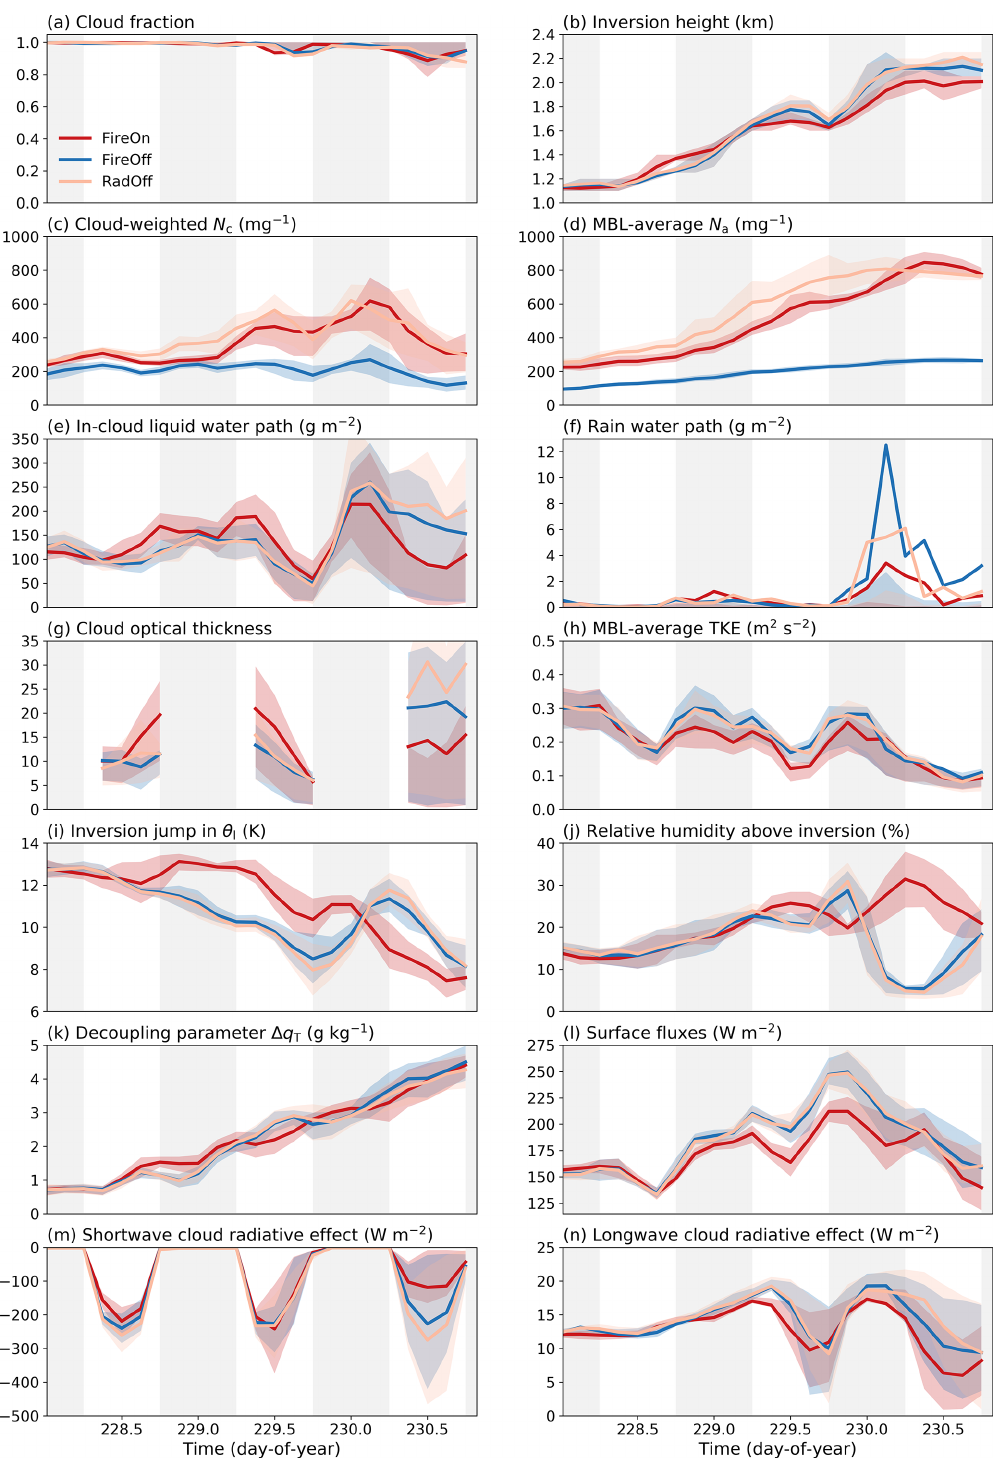
Figure 7. Various cloud, aerosol, and MBL characteristics over the course of the trajectory for each WRF-CAM5 case. Lines represent means and shading interquartile ranges of (a) cloud fraction, (b) inversion height, (c) cloud-weighted N c , (d) MBL-average N a , (e) in-cloud liquid water path, (f) rain water path, (g) cloud optical thickness, (h) MBL-average turbulent kinetic energy, (i) inversion jump in liquid water potential temperature, (j) above-cloud relative humidity, (k) decoupling parameter, (l) turbulent surface fluxes (latent plus sensible), (m) shortwave cloud radiative effect, and (n) longwave cloud radiative effect for FireOn (red), FireOff (blue), and RadOff (pink). White backgrounds indicate daytime and grey